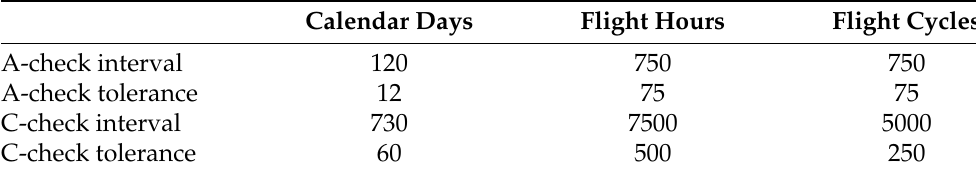
Table 2. A/C-check interval and tolerance for the Airbus A319, A320, and A321. Calendar